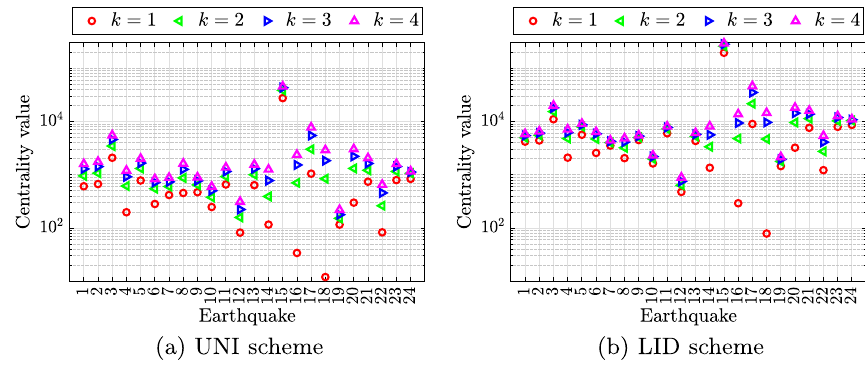
Fig. 2 Weighted degree centrality values